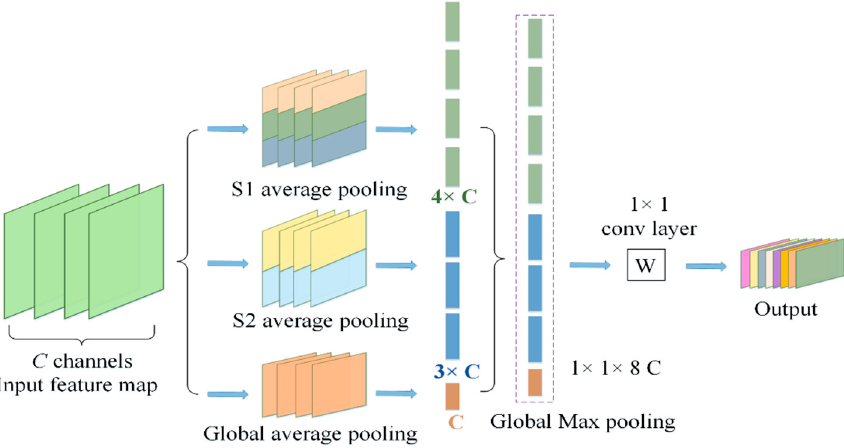
Figure 5. Schematic diagram of MGN structure.